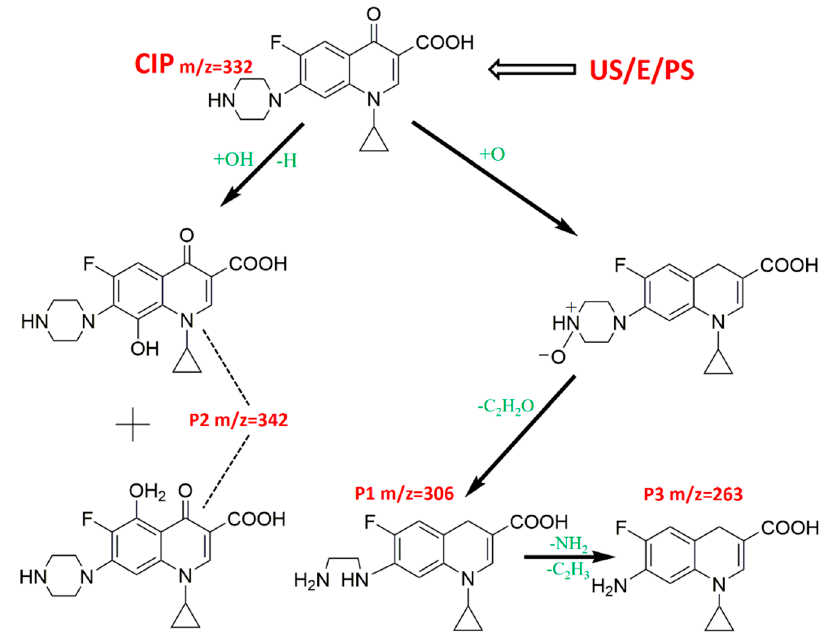
Figure 12. Path of degradation of ciprofloxacin by the US/E/PS system.